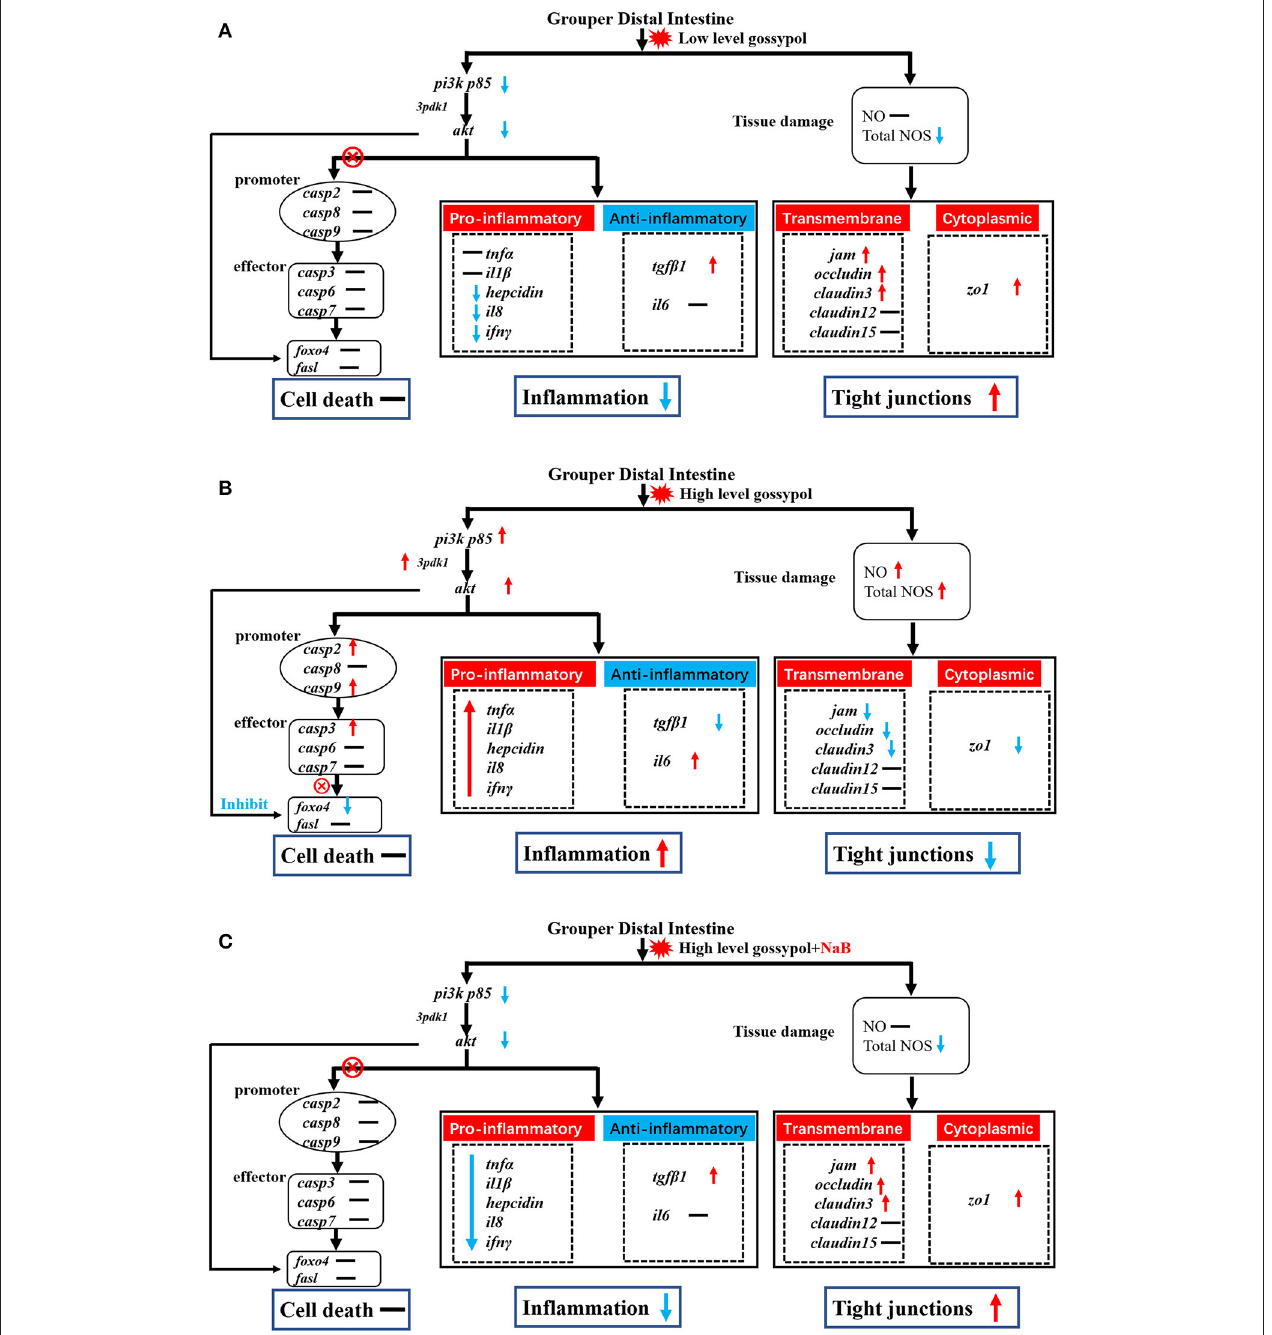
FIGURE 4 | Potential signal transduction in the distal intestine of hybrid grouper. Casp: caspase. → , through; ⊗ → , not through; red arrow, upregulation; blue arrow, downregulation. (A) group gL; (B) group gH; (C) group gHNaB.